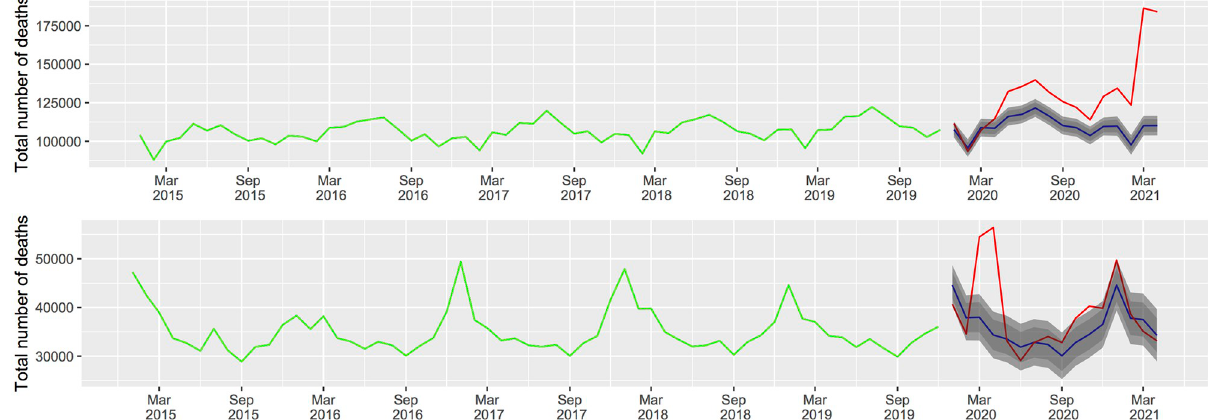
Fig 3. Total number of deaths by all causes observed and forecast of the ARIMA models. Left hand side Brazil; right hand side Spain; the green line corresponds to the observed deaths from January 2015 to December 2019; the red line corresponds to the observed deaths from January 2020 to April 2021; the blue line corresponds to the forecasts in the absence of the COVID-19 pandemic based on the ARIMA models with their respective prediction intervals. Lags units in months.